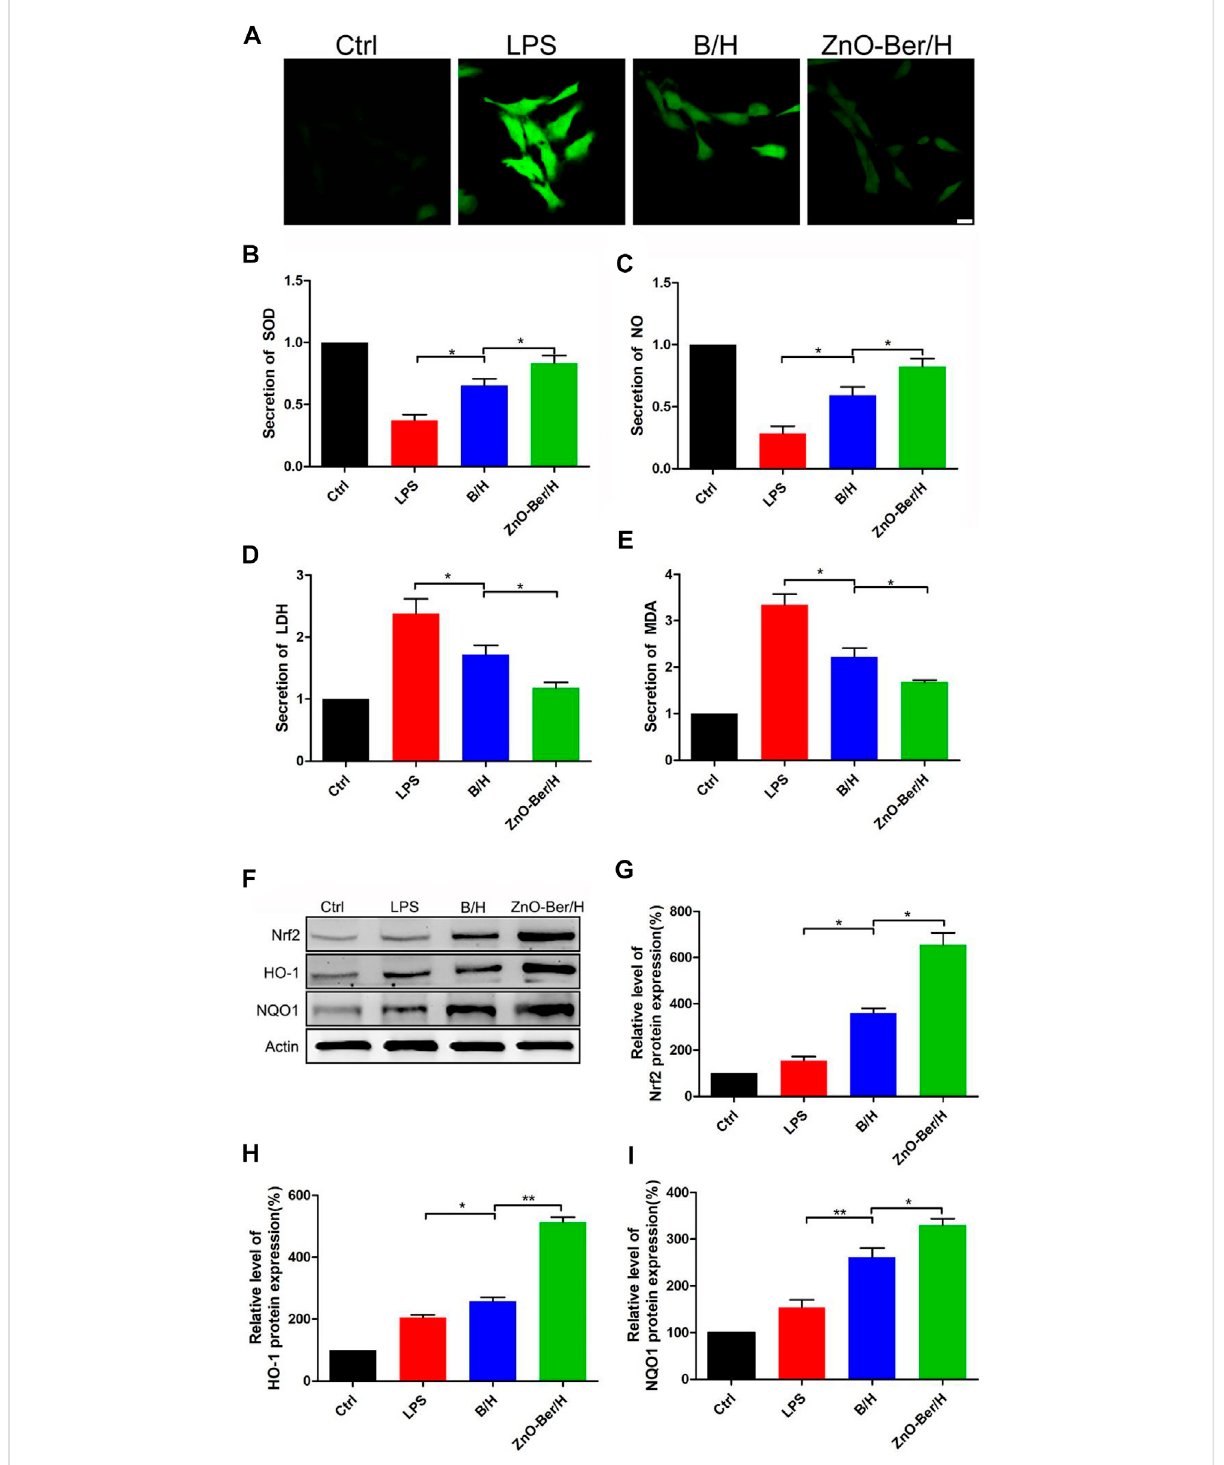
FIGURE 4 ZnO-Ber/H regulatedreactiveoxygen productioninducedbyDCFH-DA. Nrf2/HO-1/NQO1 signal pathway participatedintheprocessofZnO- Ber/H combating oxidative damage. (A) Confocal fl uorescence microscope examinations of intracellular ROS levels of NIH-3T3. (B) Supernatant detections of SOD from NIH-3T3. (C) Evaluation of NO secretion from NIH-3T3. (D) Supernatant detections of LDH from NIH-3T3. (E) Supernatant detections of MDA from NIH-3T3. (F) Western blot detection of expression of Nrf2, HO-1, and NQO1 proteins in NIH-3T3. (G – I) The relative expression analysis of western blot data. Scale bar: 25 μ m. Statistical analysis: *p ≤ 0.05, **p ≤